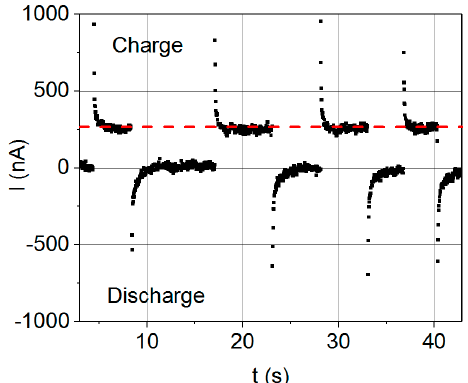
Figure 9. Several charge and discharge cycles for the triple dielectric layer capacitor, representing the intensity ( I ) flowing through the ammeter of the circuit as a function of time ( t ). An offset current (red dashed line) can be observed for charge cycles, revealing the leakage current of the capacitor.